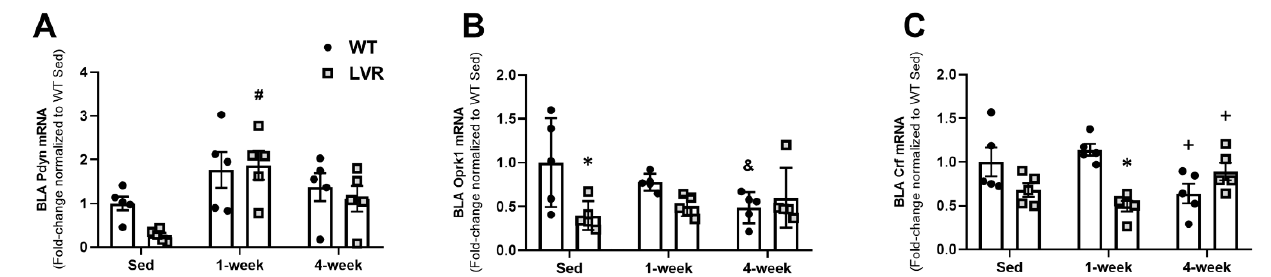
Figure 3. Effect of 1 versus 4 week(s) of wheel-running on BLA mRNA expression of ( A ) Pdyn , ( B ) Oprk1, and ( C ) Crf in WT (n = 5/group) and LVR (n = 5/group) rats compared to sedentary controls. * Denotes significant post-hoc difference ( p < 0.05) between groups within timepoint. # post-hoc difference ( p < 0.05) relative to within group sedentary animals. + post-hoc difference 4 weeks vs. 1 week within group ( p < 0.05) and post-hoc difference 4 weeks vs. sed ( p < 0.05). Values shown as mean ± SE.